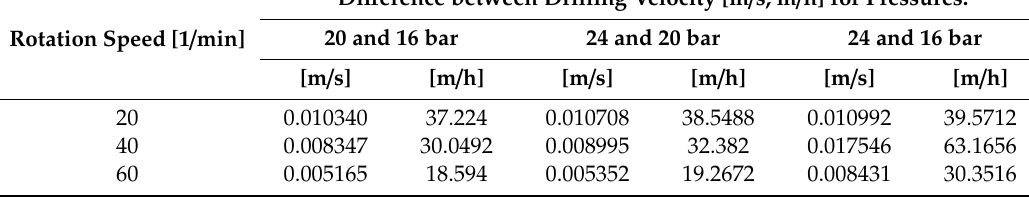
Table 4. Di ff erences between drilling velocity measured for various air pressures and drill rotation speeds of the 127 mm diameter drill bit, in the interval 54–72 m below ground level.